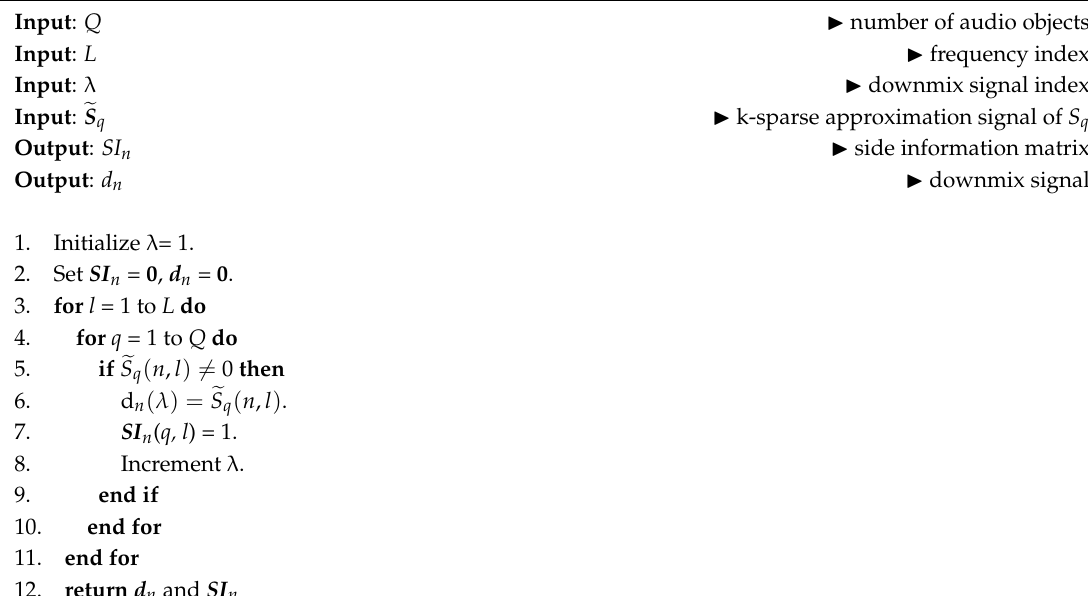
Algorithm 2: Downmix processing compression algorithm